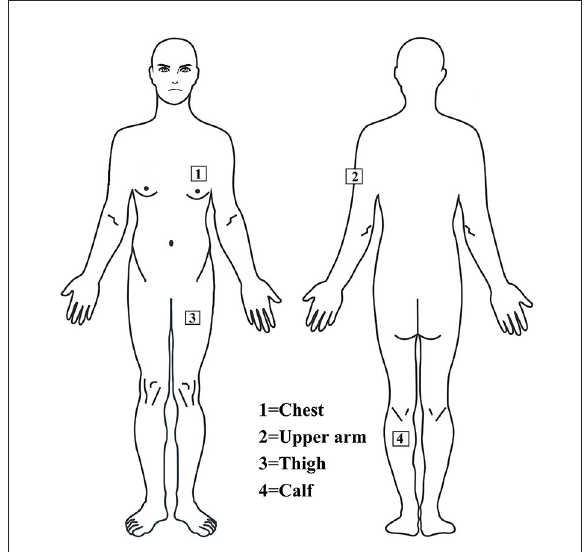
FIGURE2 Thermistor probes are installed on the chest, upper arm, thigh and leg to measure skin temperature.